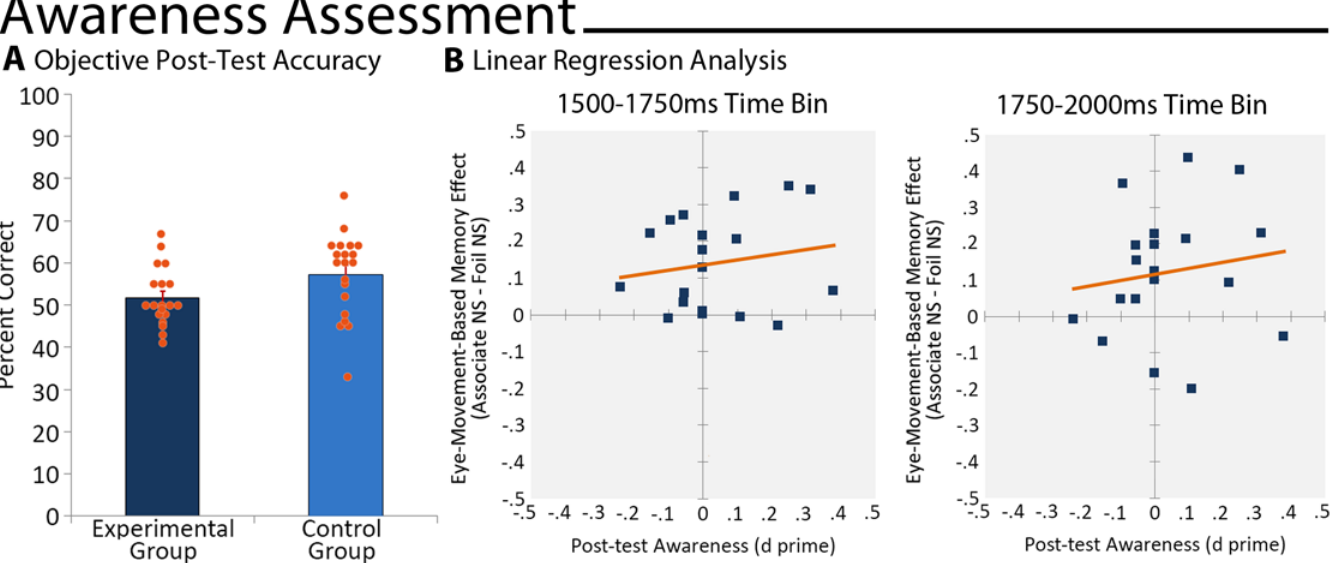
Fig 6. Identification of Subliminal Scene Cues. A) Percentage of scenes that were correctly identified when the objective forced-choice test of scene awareness was adminstered. Results from individual participants are superimposed on the bar graph (orange circles). B) Magnitude of the eye-movment- based memory effects from the 1500 – 1750ms (left) and 1750 – 2000ms (right) time bins plotted as a function of post-test awareness (d ’ scores). The regression line for each comparison is